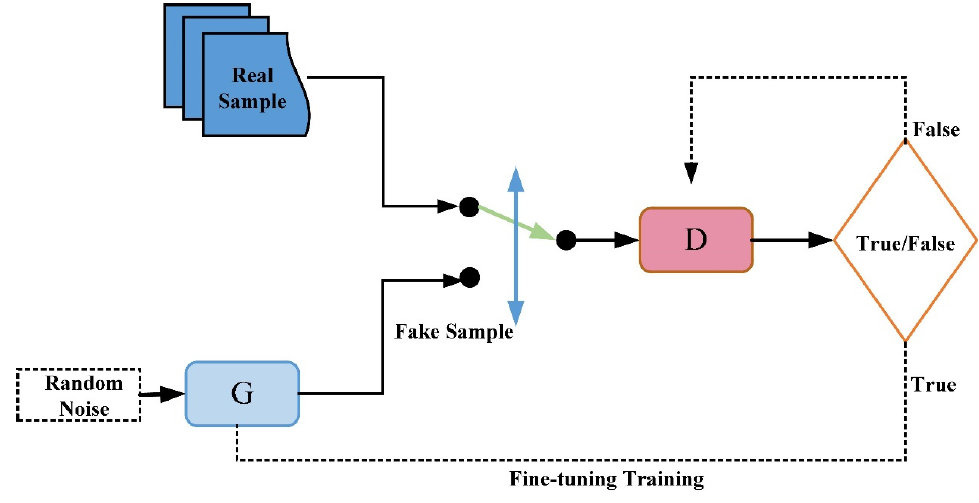
Figure 1. Architecture of